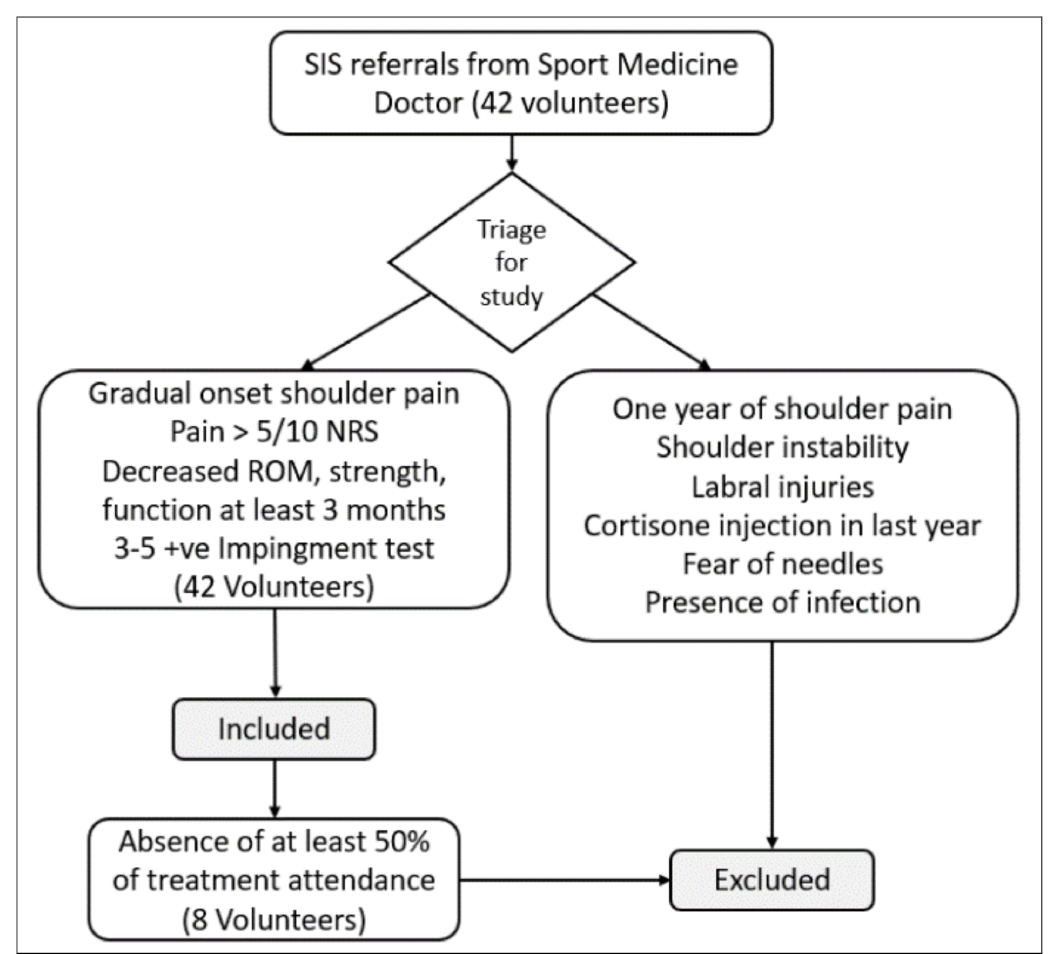
Figure A1. SIS: Subacromial Impingement Syndrome, NRS: Numerical Rating Scale, ROM: Range of motion, +ve: